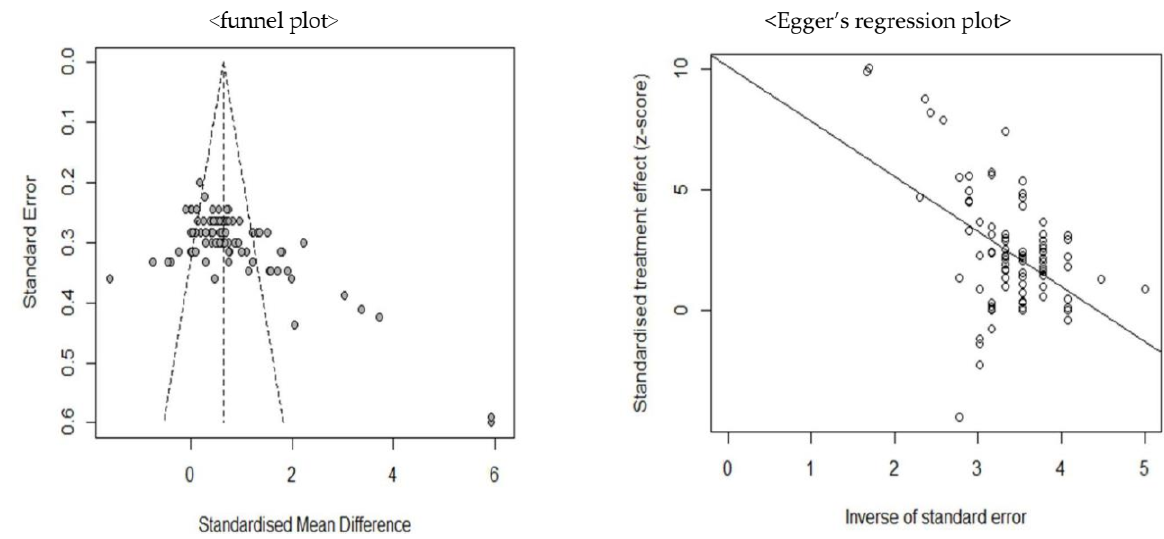
Figure 6. Publication bias analysis.